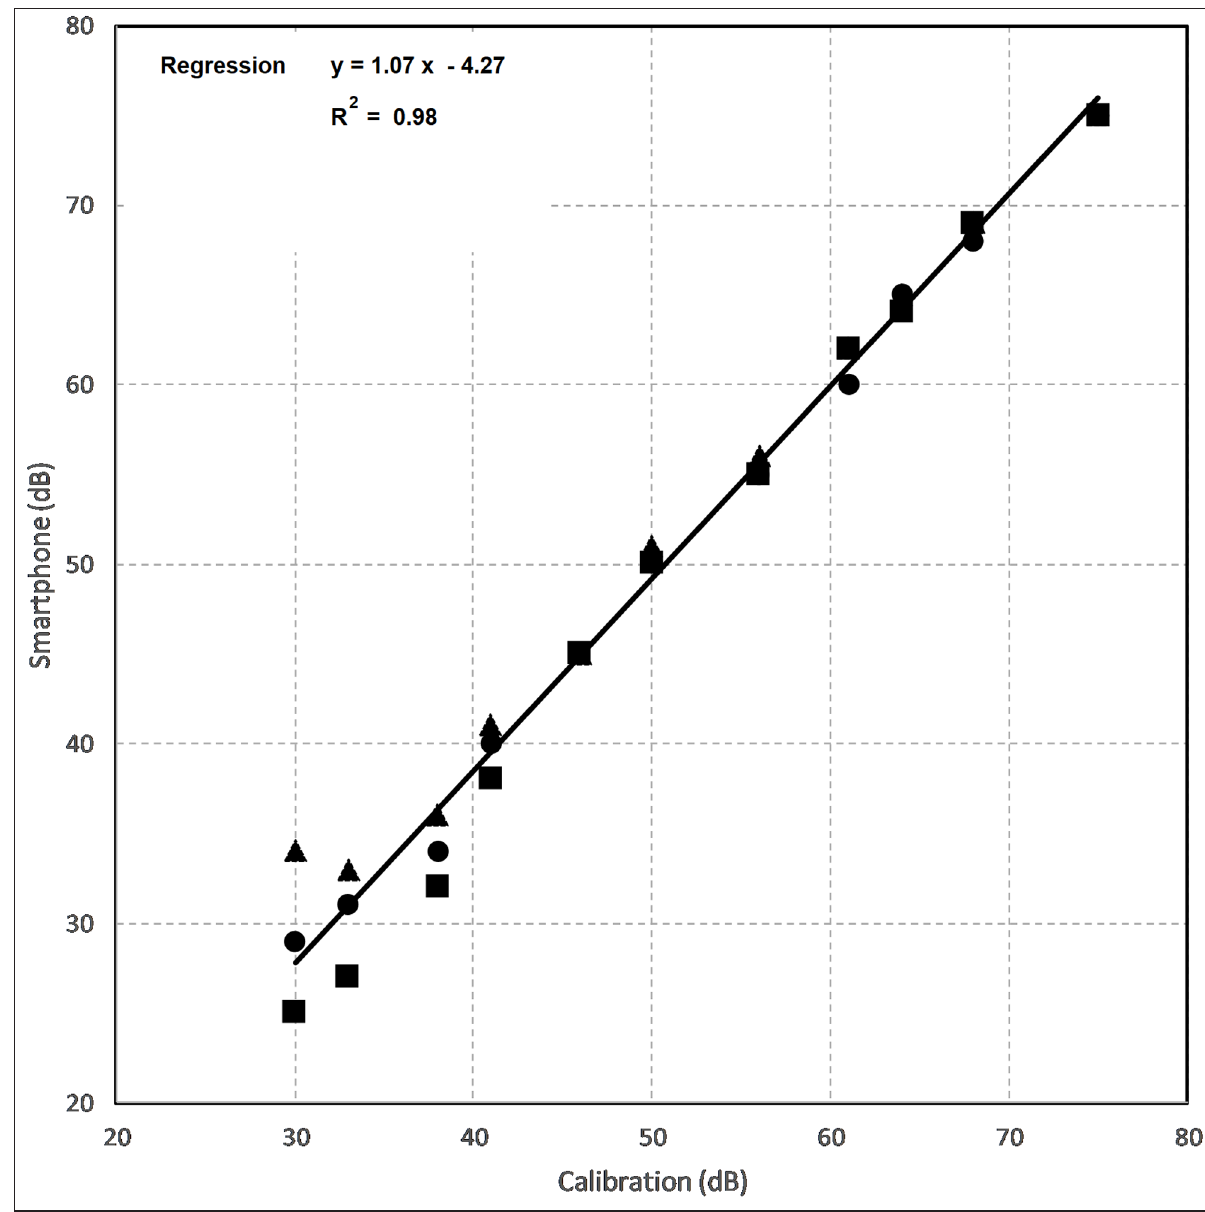
Figure 7: iPhone 6s ( dot ), Samsung Note 5 ( square ) and Galaxy S8 ( triangle ). The smartphone data obtained by the Decibel 10 th app has been shifted by: Note 5 (−12 dB), Galaxy S8 (+5 dB), and iPhone (−8 dB) to place them as close as possible to the same linear regression calibration curve ( solid line